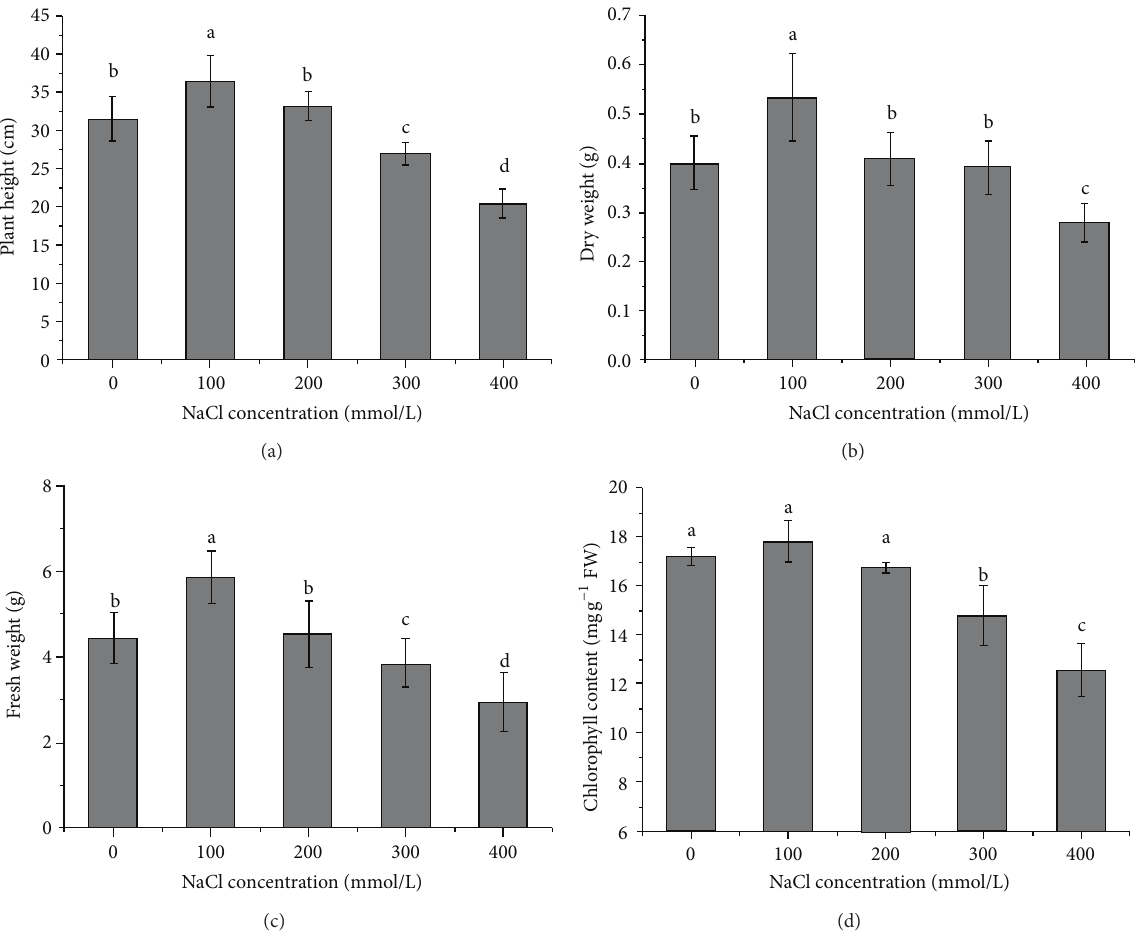
Figure 1: Changes of plant height (a), dry weight (b), fresh weight (c), and chlorophyll content (d) in seedlings exposed to different NaCl